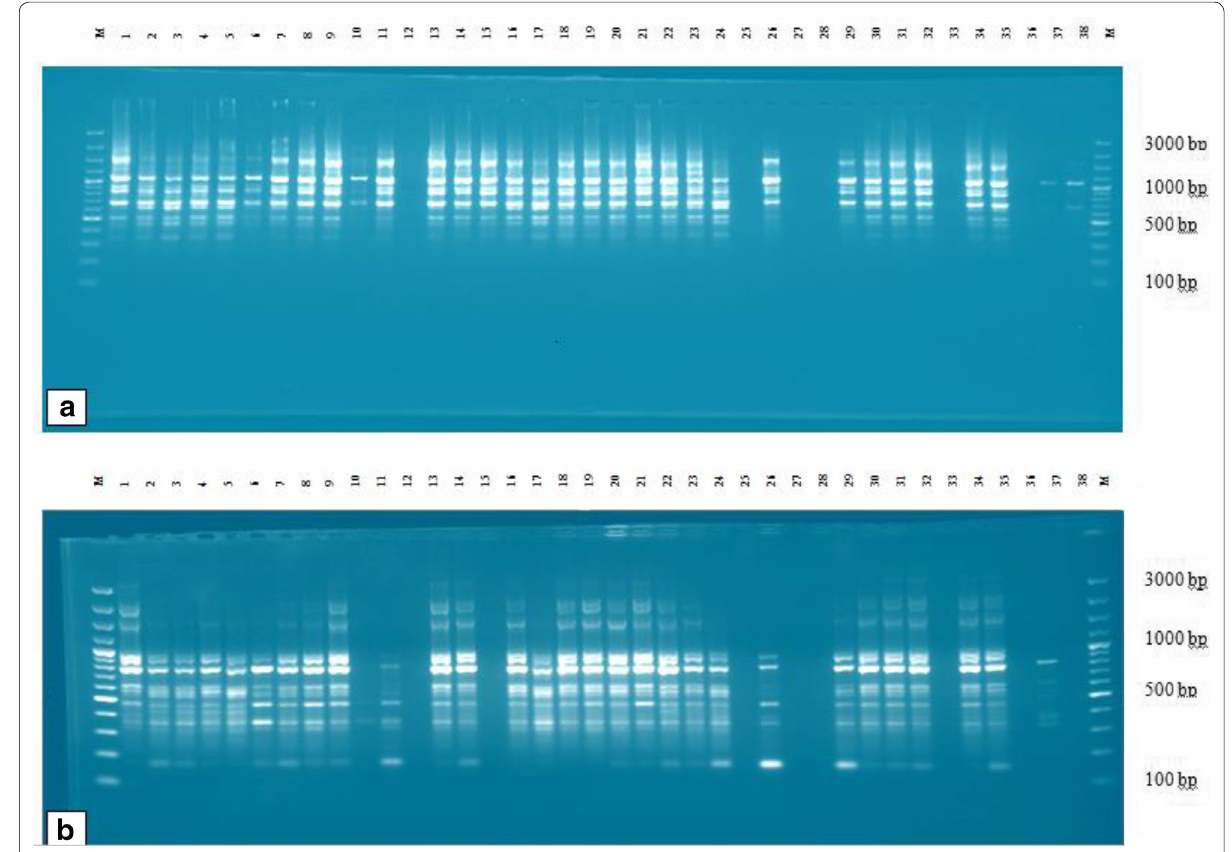
Fig. 2 ISSR profile from amplification of genomic DNA of 38 individuals of A. corrorima with primers UBC-825 ( a ) and UBC-834 ( b ). (M ladder)